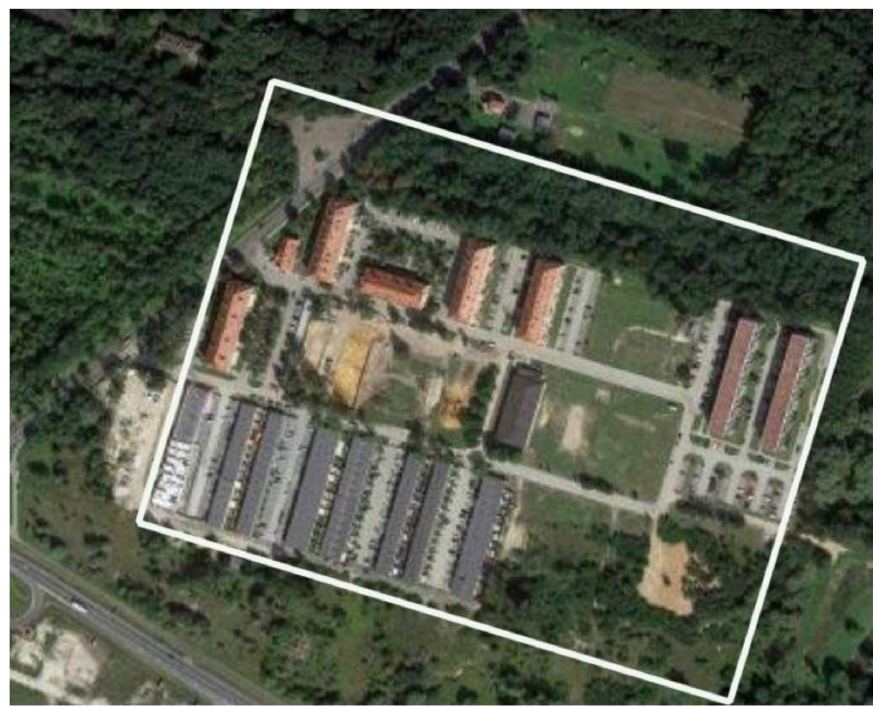
Figure 9. Localization of the site of Kasernen Siegeshöhe (map source: